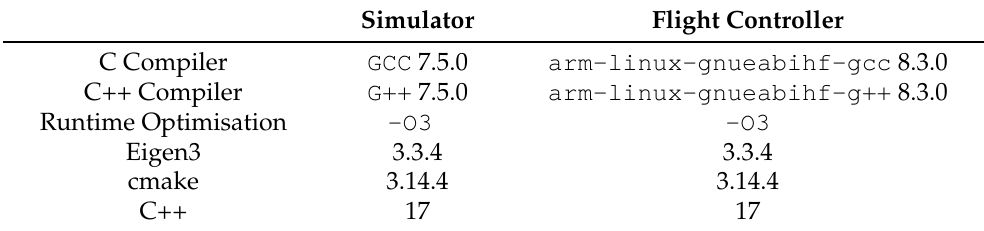
Table 6. Toolchain for building flight controller and simulator applications.